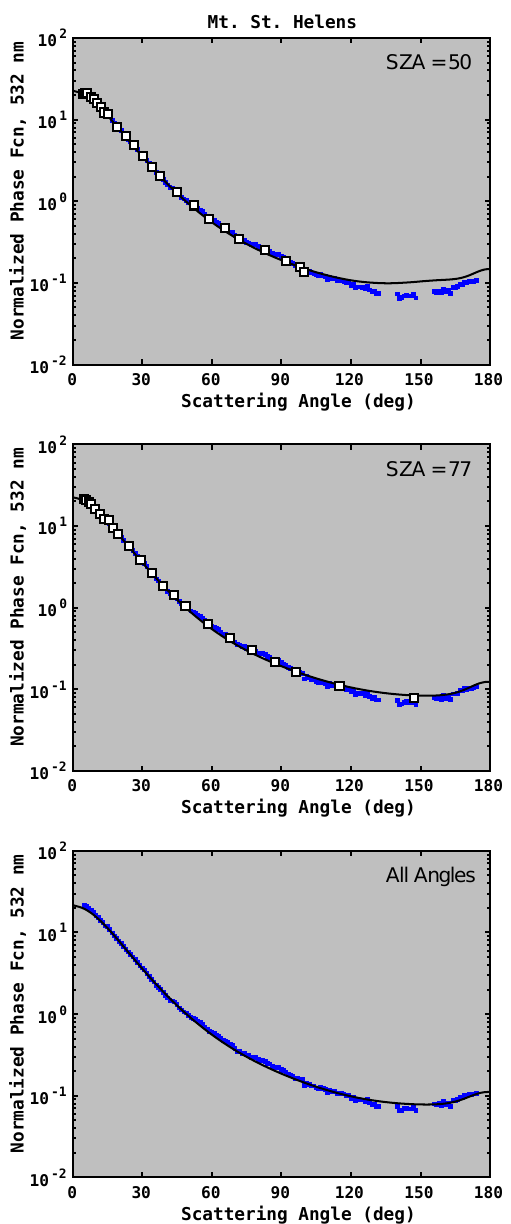
Figure 3. Illustration of AERONET angular sampling for one of the test samples (volcanic ash from Mt. St. Helens, PM 1 size cut). The small blue dots show the normalized phase function (532 nm wavelength) measured with the PI-Neph and averaged to one degree; these are identical in all three panels. The large squares in the top panel indicate subsampling used by AERONET instruments at a solar zenith angles of 50 degrees, while the squares in the middle panel indicate subsampling used by the AERONET instruments at a solar zenith angles of 77 degrees. The solid black lines in the top two panels show the phase function retrieved by the GRASP algorithm using the subsampled angles (squares). The black line in the bottom panel shows the retrieved phase function when the GRASP algorithm uses all available measurements (small blue